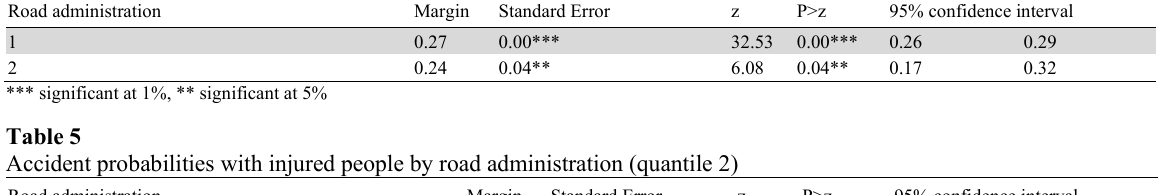
Accident probabilities with injured people by road administration (quantile 2) Road administration Margin